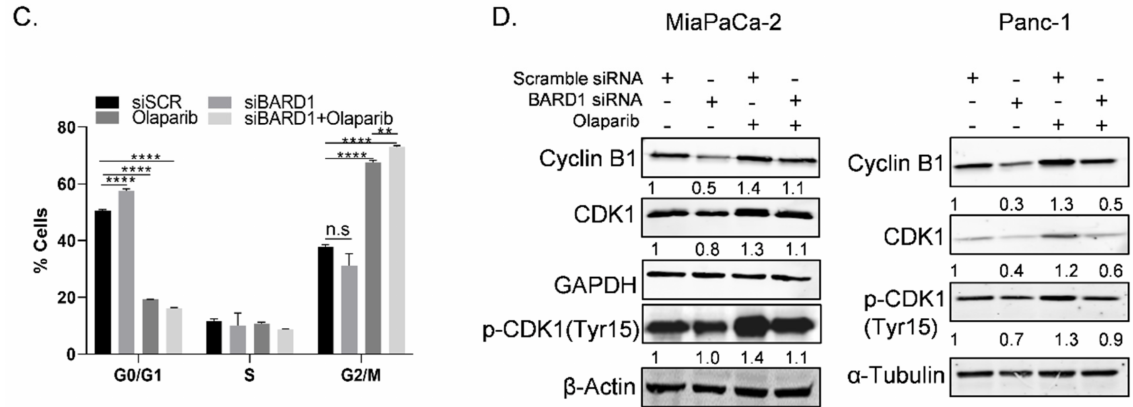
Figure 5. Knockdown of BARD1 increases drug induced DNA damage. ( A ) Comet assay showing an increase in olaparib (10 µ M) induced DNA damage when cells were transfected with siBARD1 (siBARD1#1) as compared to siSCR control (the scale bar: 10–50 µ M). Representative images from n = 3 and a graph of percentage Tail DNA is shown. Mean ± SEM. * p < 0.05, **** p < 0.0001, n.s, non- significant. (One-way ANOVA, Dunnett’s correction) ( B ) Immunofluorescence staining of γ -H2AX foci in siBARD1 (siBARD1#1) cells treated with or without olaparib (10 µ M) for 24 h in MiaPaCa-2 and Panc-1 cells (the scale bar: 1–10 µ M). Representative images from n = 3 are shown. Mean ± SEM. * p < 0.05, ** p < 0.01, *** p < 0.001, **** p < 0.0001 (Student’s t -test). ( C ) Graph showing different phases of the cell cycle as quantitated by flow cytometry and PI staining in MiaPaCa-2 cells transfected with siBARD1 (siBARD1#1) and treated with or without olaparib (10 µ M) for 24 h. Mean ± SEM from n = 3. ** p < 0.01, **** p < 0.0001, n.s, non-significant (Student’s t -test). ( D ) Western blot analysis showing protein expression of cell cycle proteins, β -actin, GAPDH, α -tubulin in MiaPaCa-2, and Panc-1 cells. Representative blots from n = 3 are